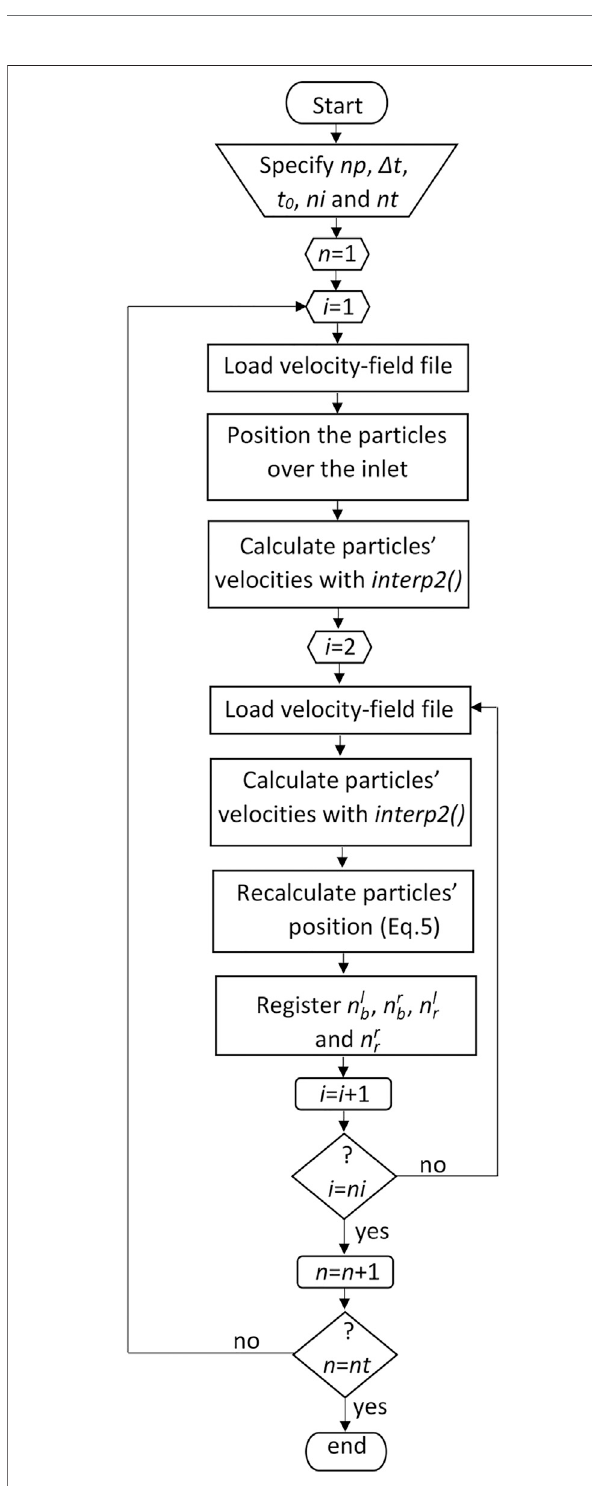
FIGURE 8 | Batch Lagrangian Mixing Simulation (BLMS) block diagram.